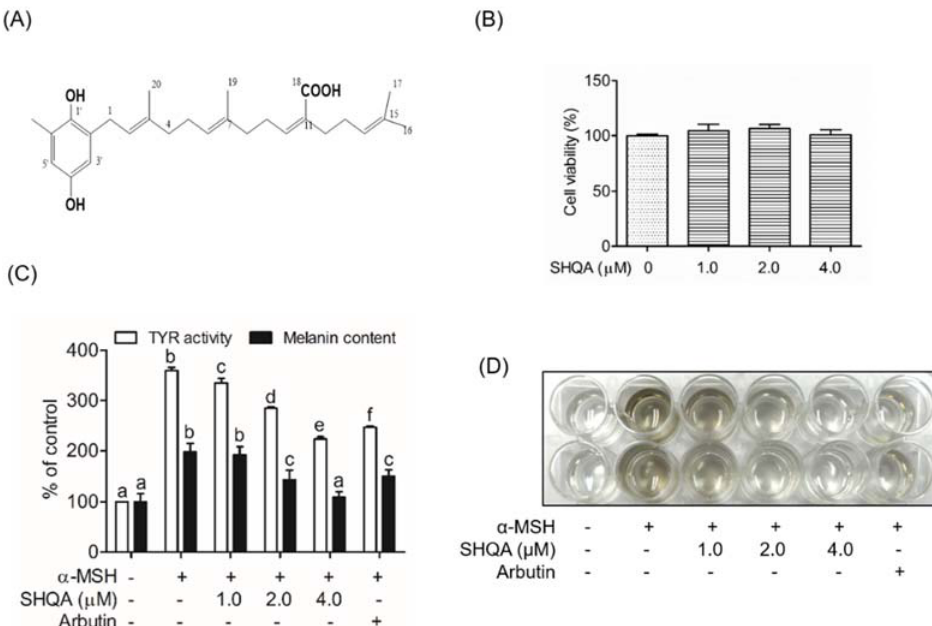
Figure 1. SHQA suppresses TYR activity and melanin production in B16F10 cells. ( A ) SHQA structure is isolated from S. serratifolium . ( B ) Cytotoxicity was measured by an MTS assay after SHQA treatment for 24 h. ( C ) After B16F10 cells were pre-treated with SHQA for 1 h, the cells were exposed to α -MSH (1.0 μ M) for 72 h with and without SHQA. The cellular tyrosinase activity and melanin content was tested by measuring absorbance. ( D ) Measurement of melanin release in the culture medium after 72 h of SHQA treatment. Data are expressed as the mean ± standard deviation (SD) ( n = 3). Different superscripts represent statistical significance at p < 0.05.